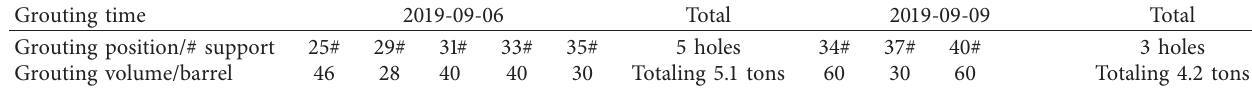
Table 3: Two grouting time and position of working face.